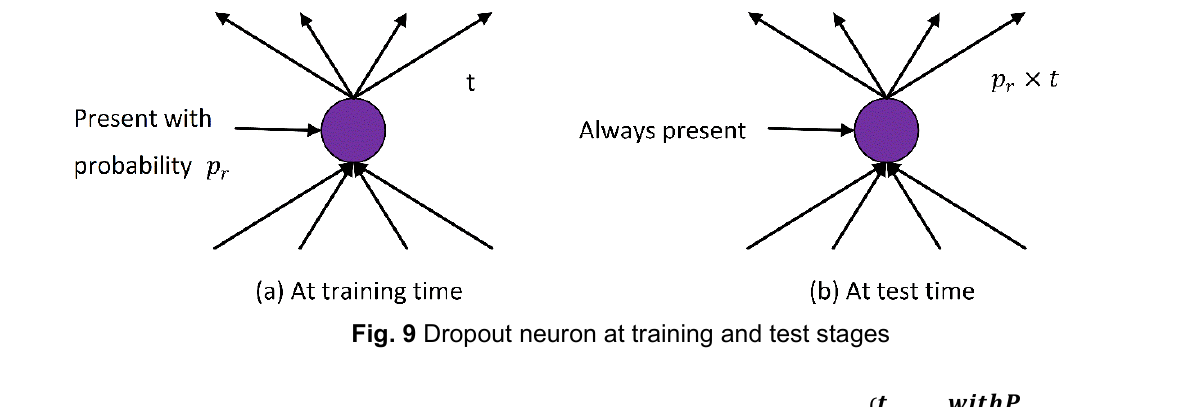
Fig. 9 Dropout neuron at training and test